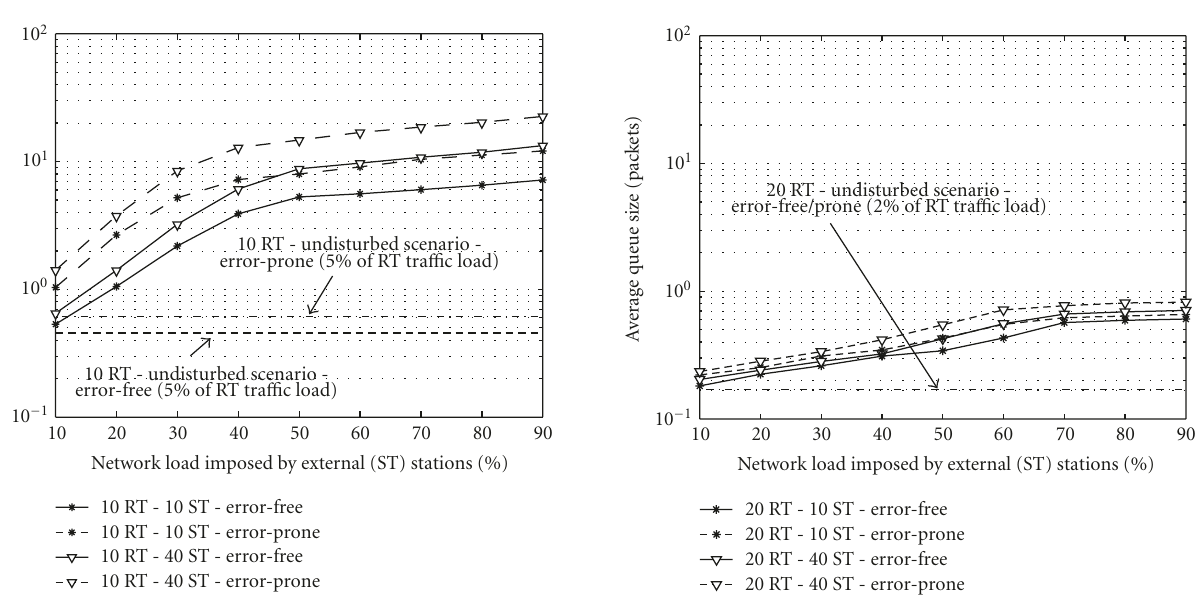
Figure 4: Average queue size (small and large pop.): error-free versus error-prone—MSP = 10 ms.